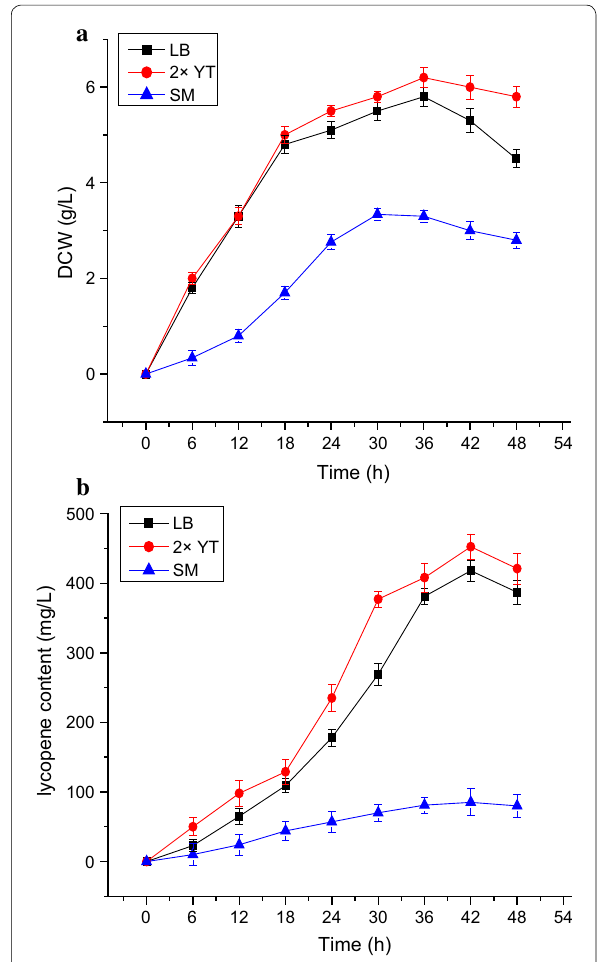
Fig. 4 Dry cell weight and lycopene yield of strain EBI in different media. a Cell dry weight from strain EBI in LB medium (black squares), 2 YT medium (red circles), and SM medium (blue triangles) with × no IPTG, after growth at 30 °C for 48 h. b Lycopene content of strain EBI in LB medium (black squares), 2 YT G medium (red circles), × + and SM medium (blue triangles) with no IPTG, after growth at 30 °C for 48 h. The data represent the means of three independent experiments. Error bars represent standard deviations